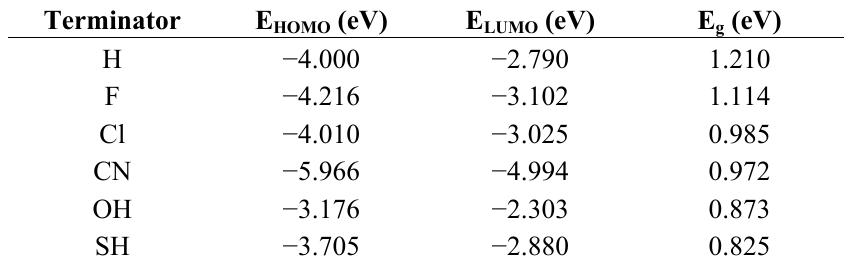
, E and E for fully terminated 6-A-HGNS. HOMO LUMO g